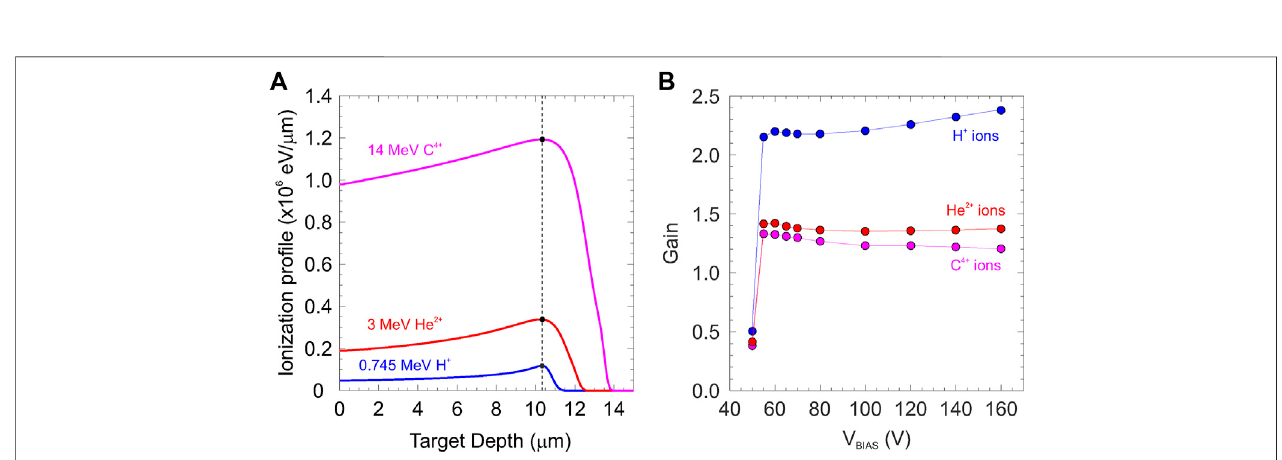
FIGURE 8 | (A) Ionization pro fi les for three ions (H, He and C) having maximum of ionization at the same depth in silicon. (B) Gain in LGAD sample C, shown as a function of bias voltage for these ions.